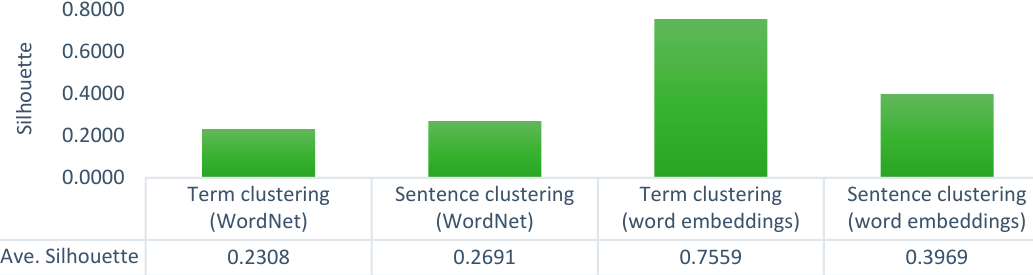
Figure 5. Average Silhouette values of compared topic detection approaches applied to the COVID-19 dataset.